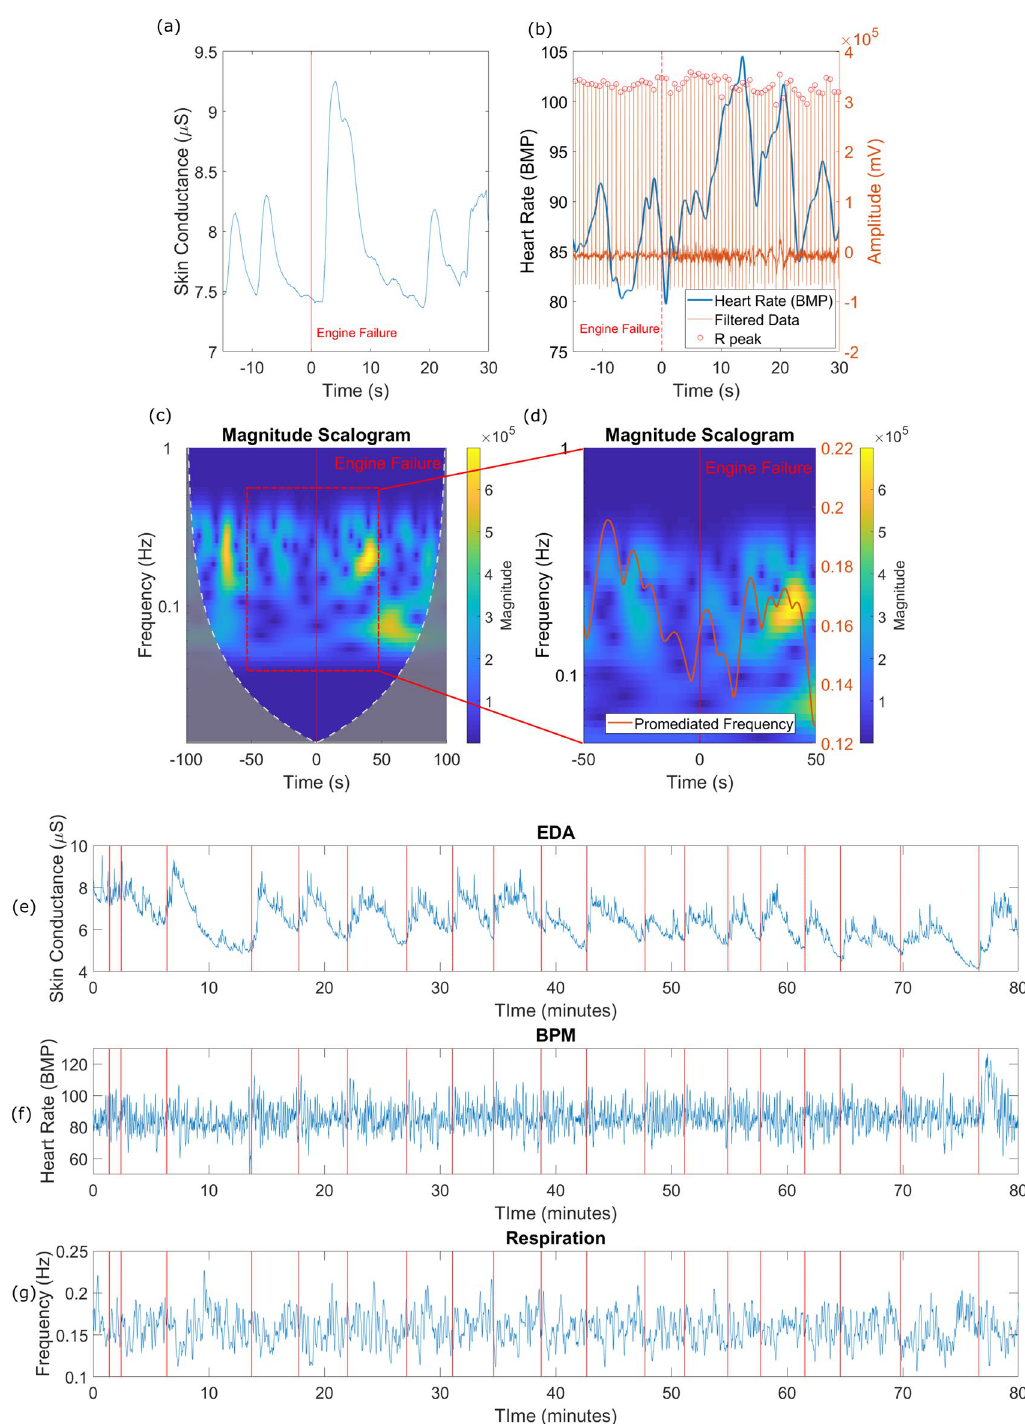
Figure 3. (a) Example of skin conductance response after engine failure. (b) Peak detection and heart rate computation. (c) Example of respiration scalogram around engine failure. (d) Zoom on the spectrogram at the frequency of interest and the promediated frequency calculated. The blue means the lowest magnitude value and red the highest. Example of the 3 physiological signals for a full flight. (e) EDA, (f) heart rate frequency, and (g) promediated respiratory frequency. The red vertical lines are the occurrence of engine